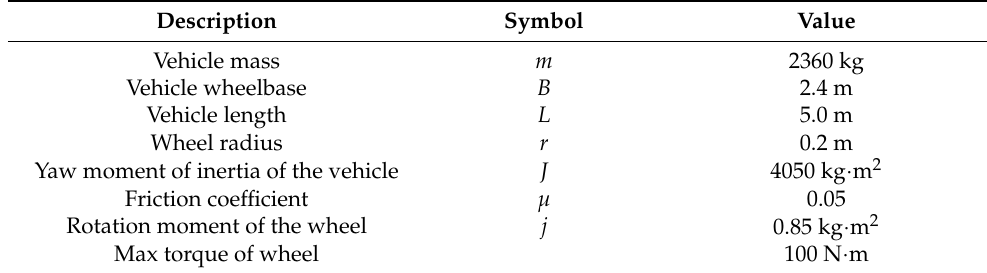
Table 1. Specifications of the dynamics model.